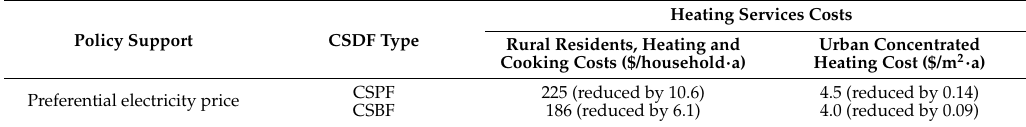
Table 12. The heating service cost of a CSDF-DHS with preferential electricity price.